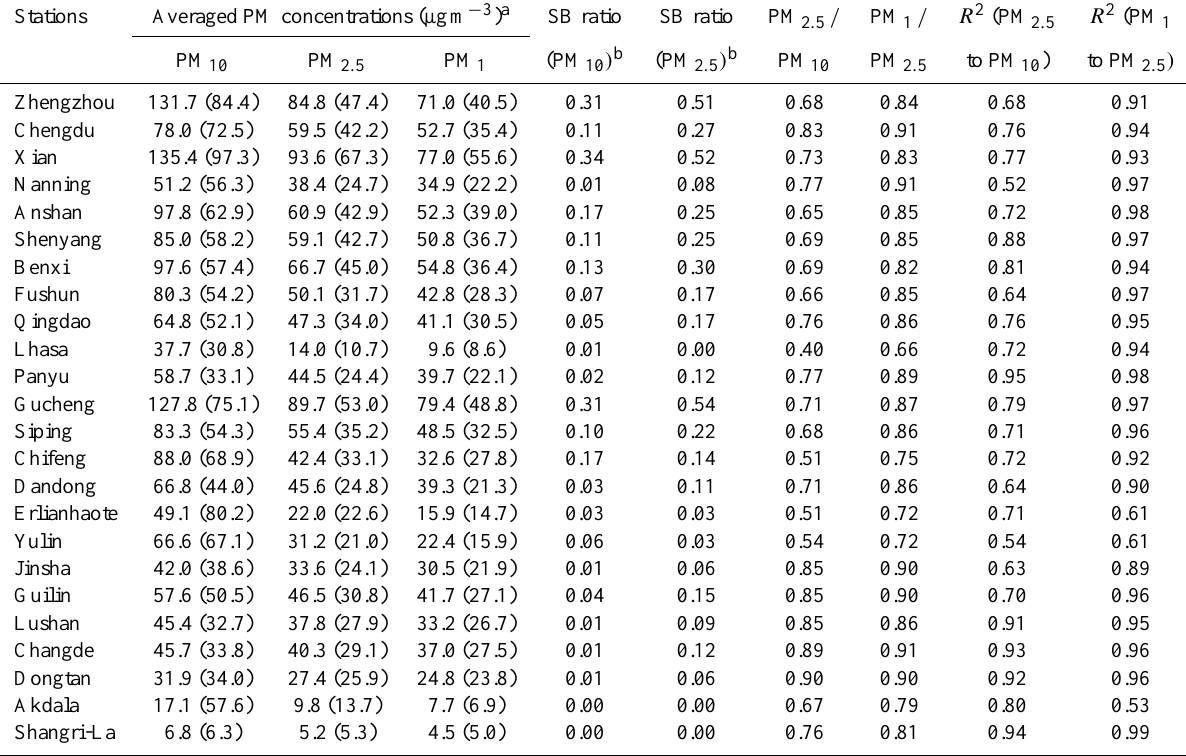
Table 2. Averaged PM 10 , PM 2 . 5 and PM 1 concentrations and their interrelationships at each station. SB = substandard. Stations